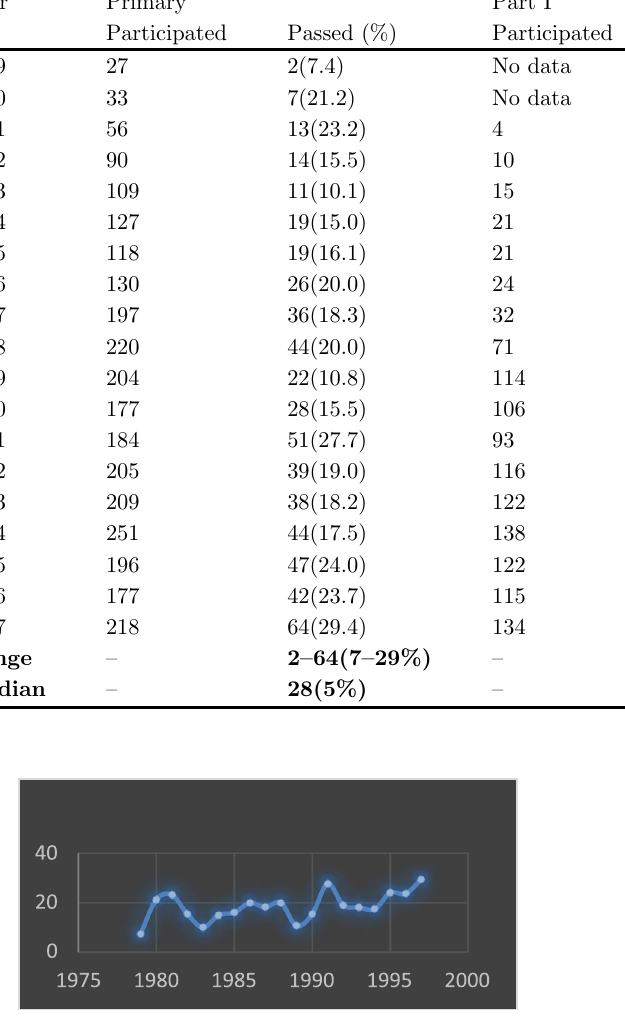
Fig. 2. Trend of WACS